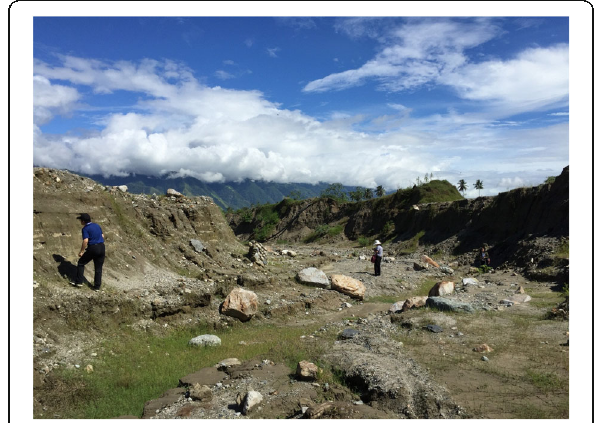
Fig. 2 The path of ground flow in Sibalaya Village